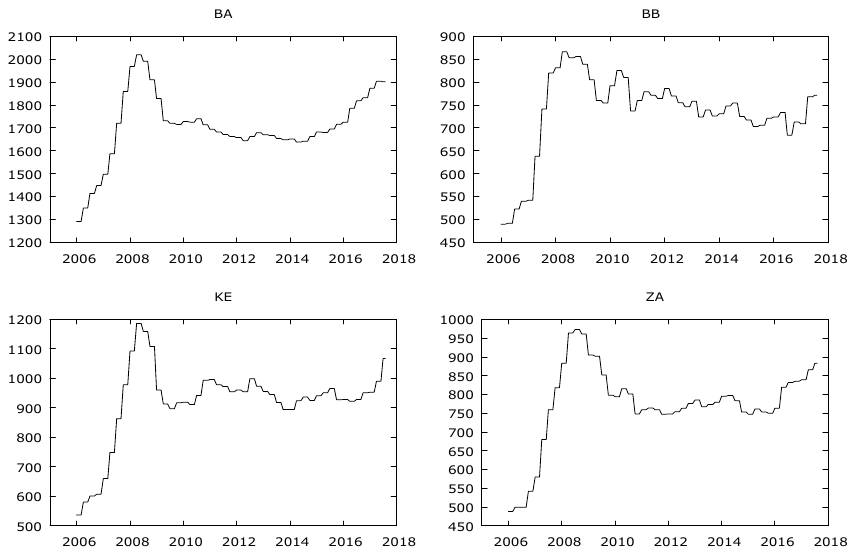
Figure 6. Residential real estate prices in the regions with the highest prices—Bratislava, Banska Bystrica, Zilina and Kosice in 2005–2018. Source: own processing using the sources of the National Bank of Slovakia 2018. BA = residential real estate prices in the Bratislava region; KE = residential real estate prices in the Kosice region; BB = residential real estate prices in the Banska Bystrica region; ZA = residential real estate prices in the Zilina region.